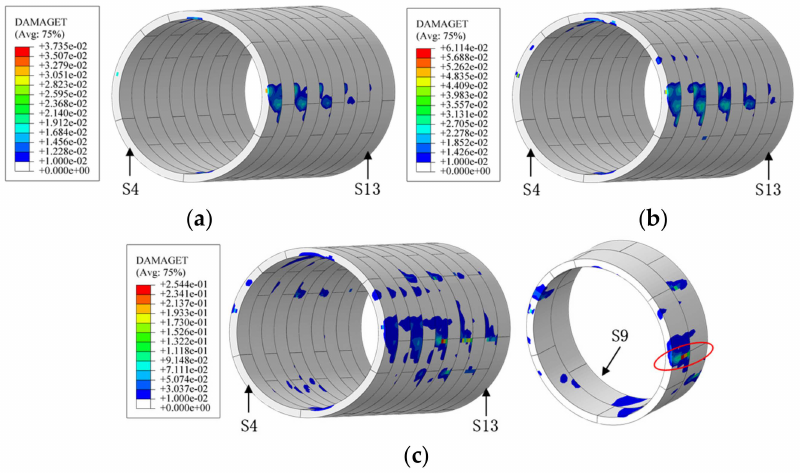
Figure 11. Tensile damage distribution of the shield tunnel under reverse faulting: ( a ) under 10 cm fault displacement, ( b ) under 15 cm fault displacement, and ( c ) under 20 cm fault displacement. Some like +3.735e-02 means 3.735 × 10 − 2 .